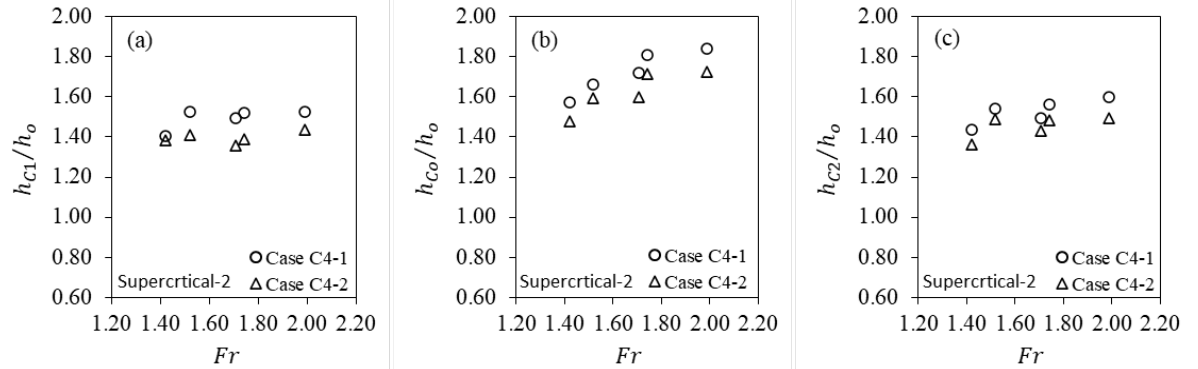
Figure 7. Non-dimensional water depth relative to the upstream water depth ( h o ) along the centerline in case C4 for the supercritical flow over the horizontal channel bed: ( a ) at point C 1 , ( b ) point C o , and ( c ) point C 2 .